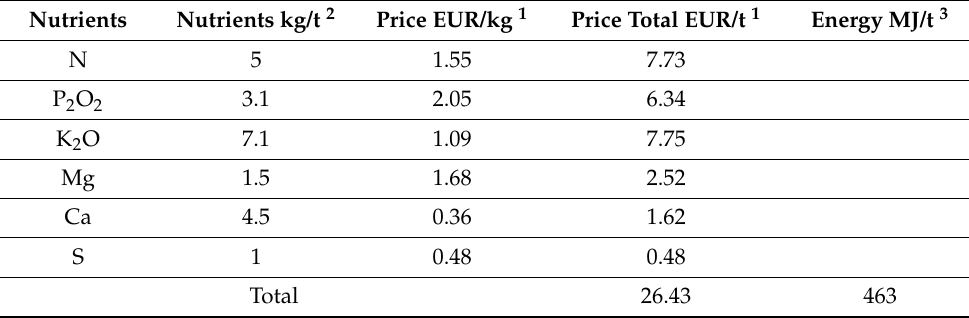
Table A7. Price and energy of nutrients in cow manure.